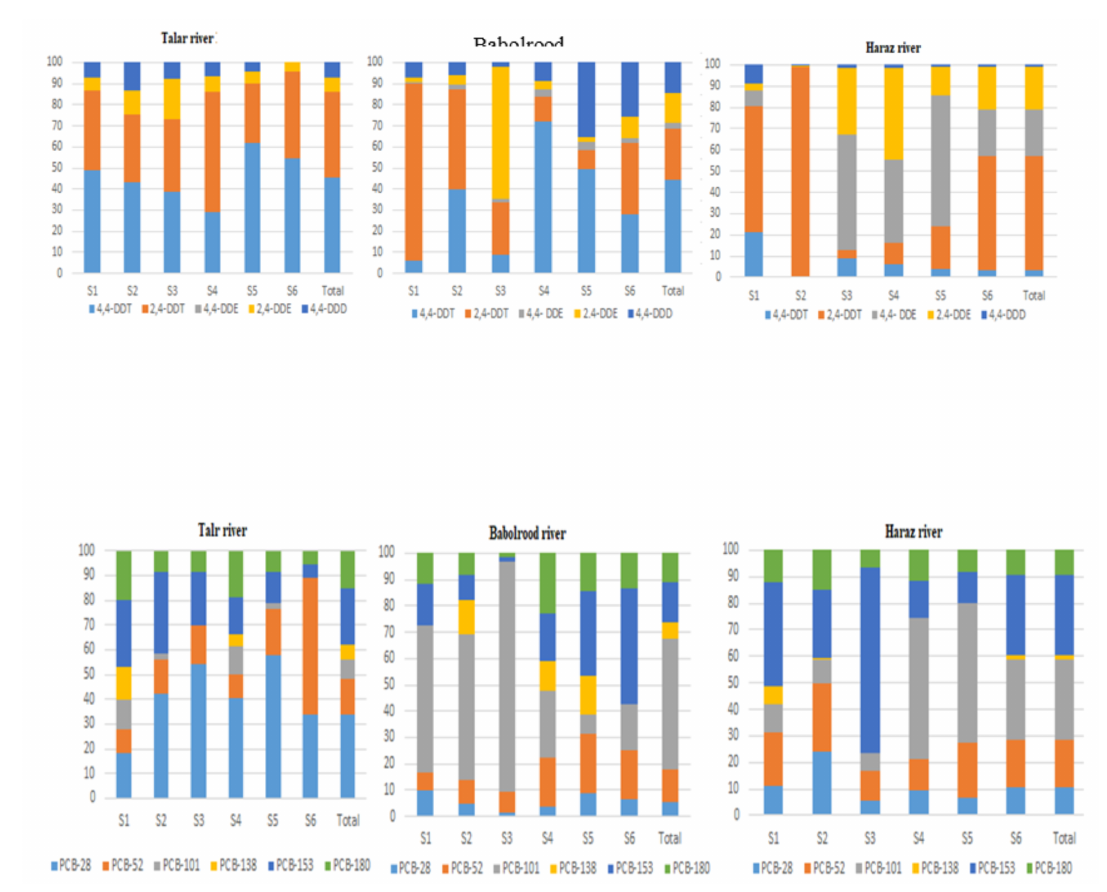
Figure 2. Average percent composition of DDT metabolites and PCB congeners in water samples from di ff erent sites (S1–S6) and sum of all sites on the Talar, Babolrood and Haraz Rivers in